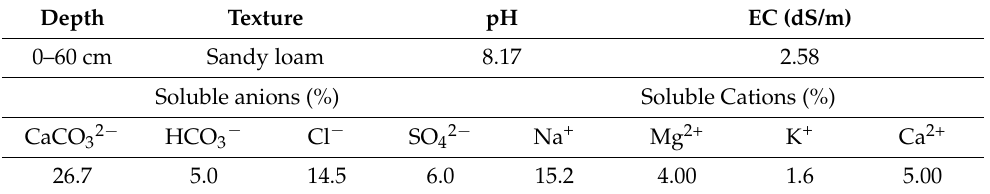
Table 1. Physicochemical properties of the experiment